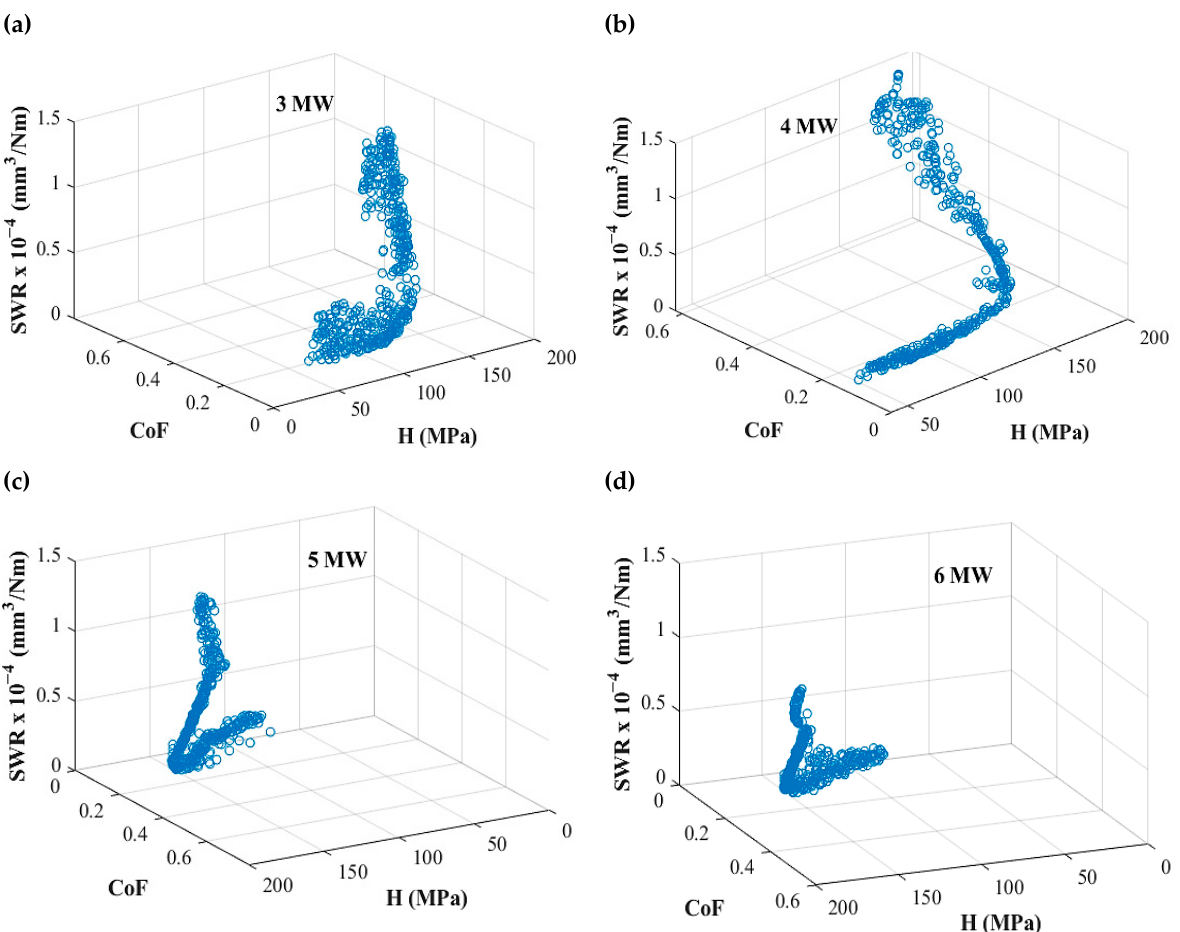
Figure 9. 3D Pareto front of H, CoF, and SWR without constraints on varying the molecular weight of UHMWPE ( a ) 3, ( b ) 4, ( c ) 5, and ( d ) 6.